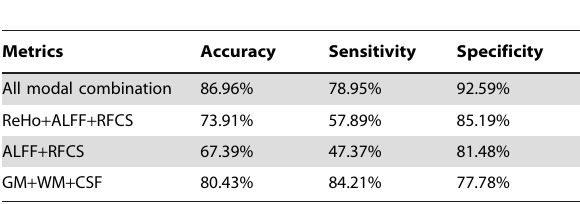
Table 3. Classification performance of the single metrics and multi-modal